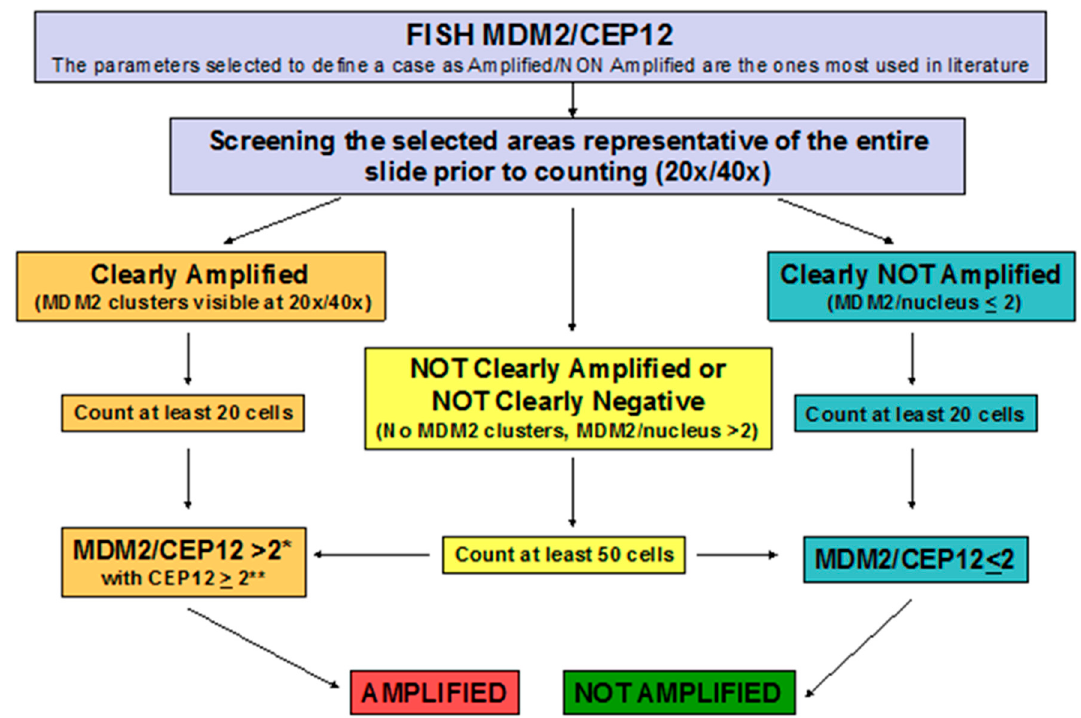
Figure 4. Criteria settled for FISH MDM2/CEP12 analysis. * Generally, cases with MDM2 amplification have a lot of MDM2 signals, so we think that an MDM2/CEP12 ratio > 2 is better than MDM2/CEP12 ≥ 2 as a diagnostic criterion. ** This parameter supports excluding cases with loss of CEP12 (CEP12 per nucleus < 2) as amplified.